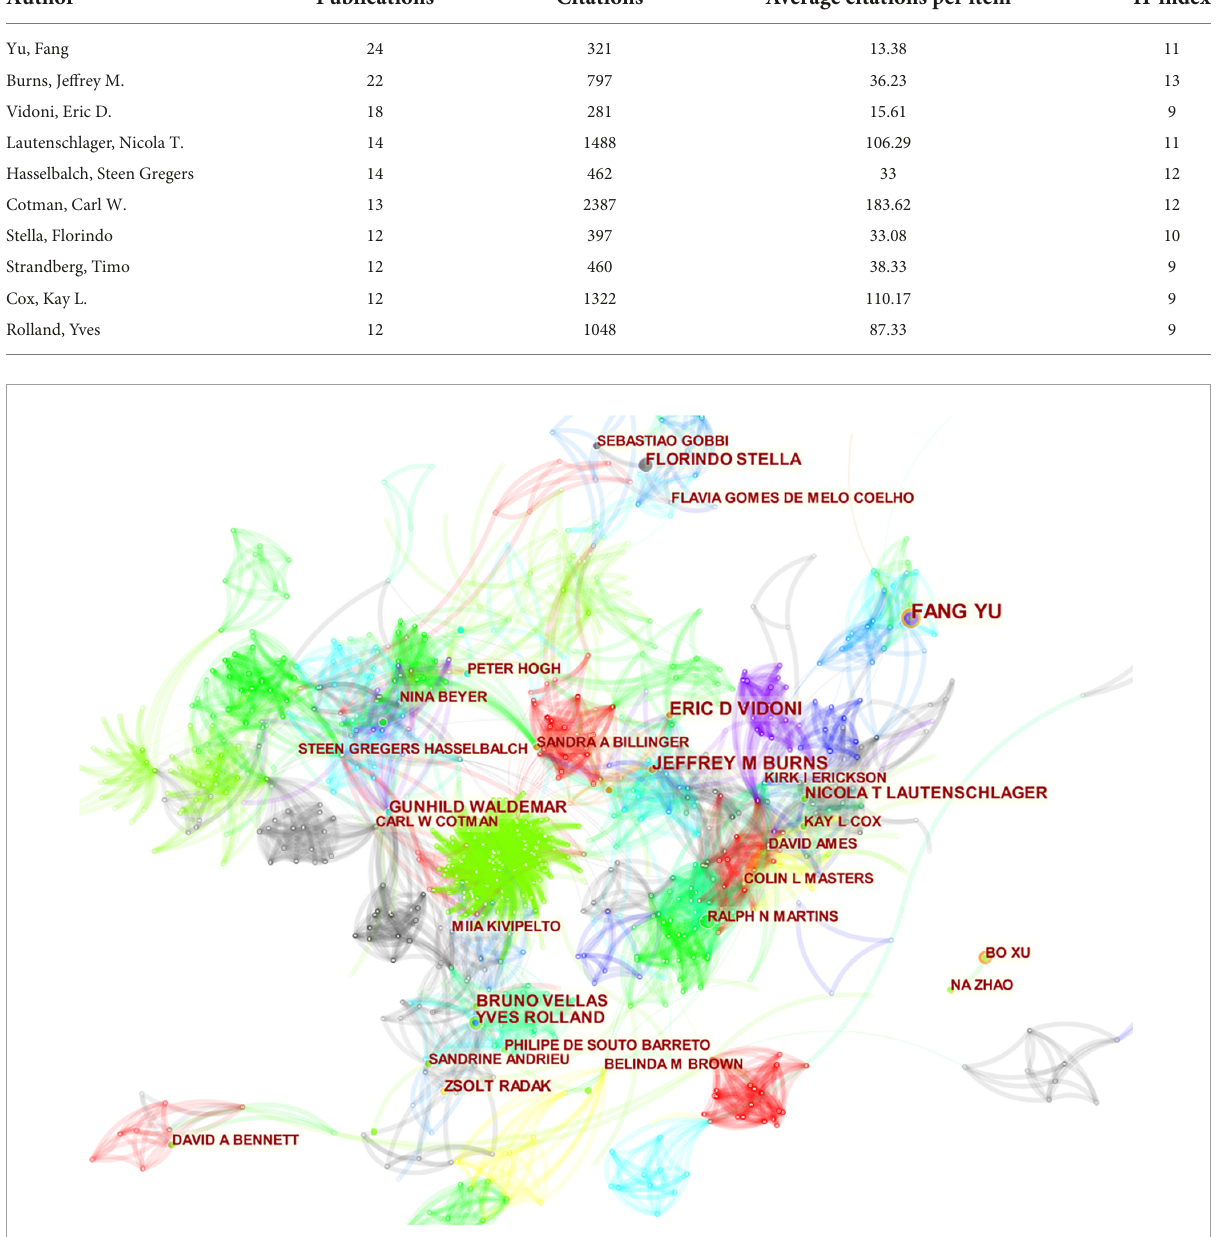
FIGURE4 The map of co-authors. The nodes in the map represent co-authors, and lines between the nodes represent co-citation relationships. The purple ring represents